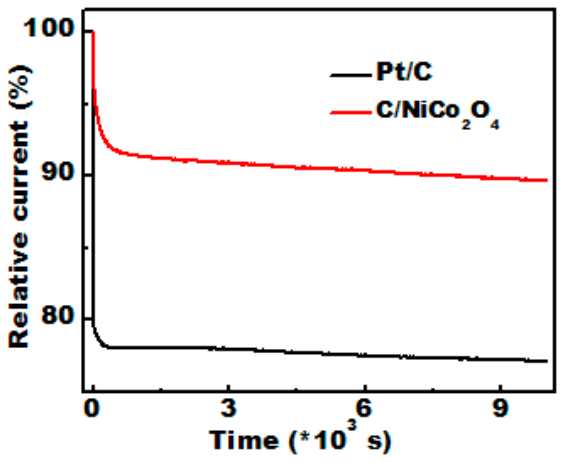
Figure 9. Nyquist plots of C/NiCo 2 O 4 and NiCo 2 O 4 nanofibers obtained at room temperature.